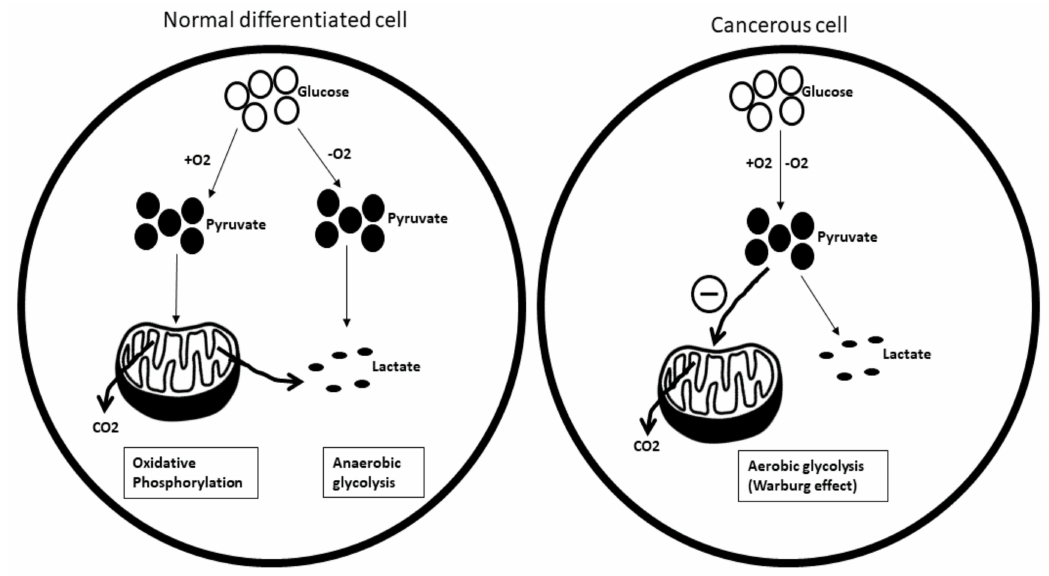
Figure 9. The differences in glucose metabolism between normal differentiated cells and cancerous cells. O 2 : oxygen; CO 2 : carbon